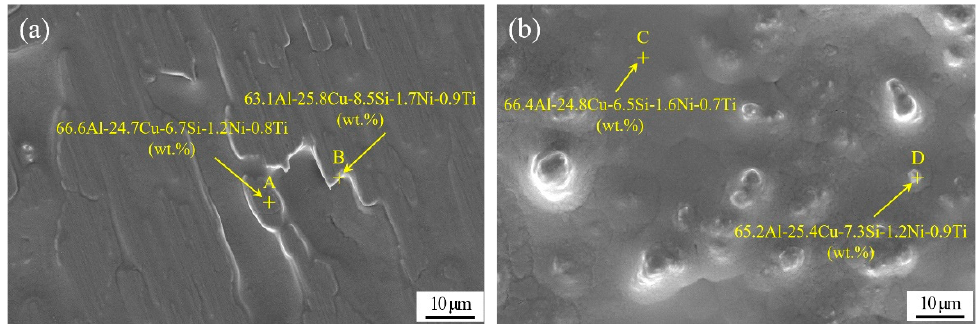
Figure 4. SEM image and EDS analysis of melt-spun ribbon of Al-7.5Si-23.0Cu-2.0Ni-1.0Ti taken from two sides: ( a ) contact surface; ( b ) free surface.